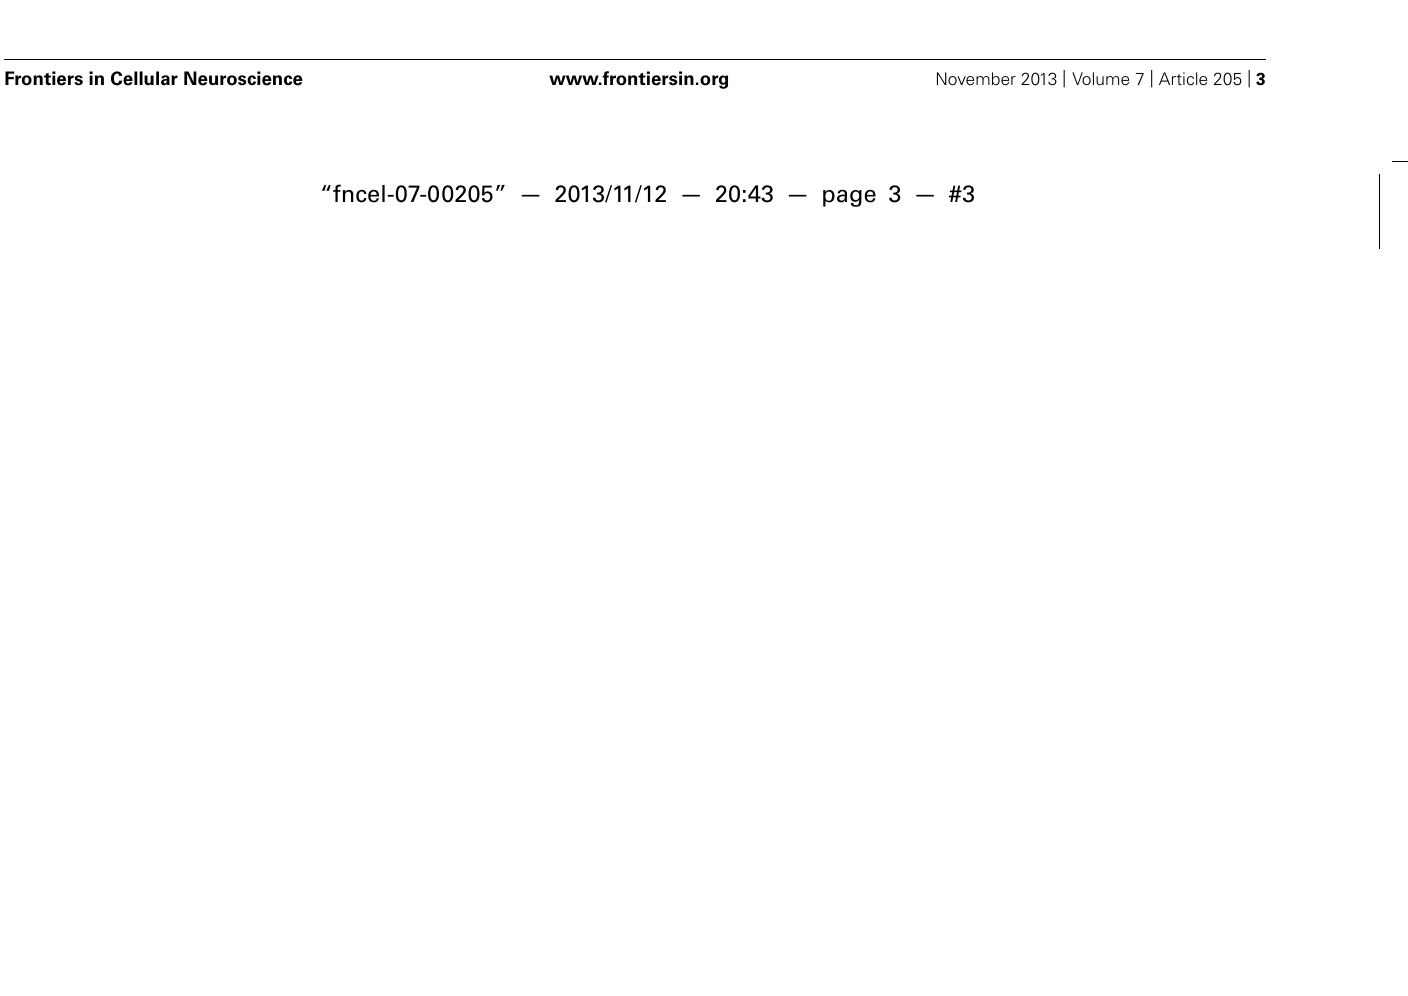
The integrated transient is represented as the arced area. (C) Enlargement of capacitive transients evoked by 10 mV increment steps from − 100 to + 40 mV starting from a holding potential of − 50 mV. (D) , I − V plot of the peak of the capacitive transient shown in (C) compared to the membrane potential.The arced line shows the linear regression between − 100 and − 20 mV ( R 2 =